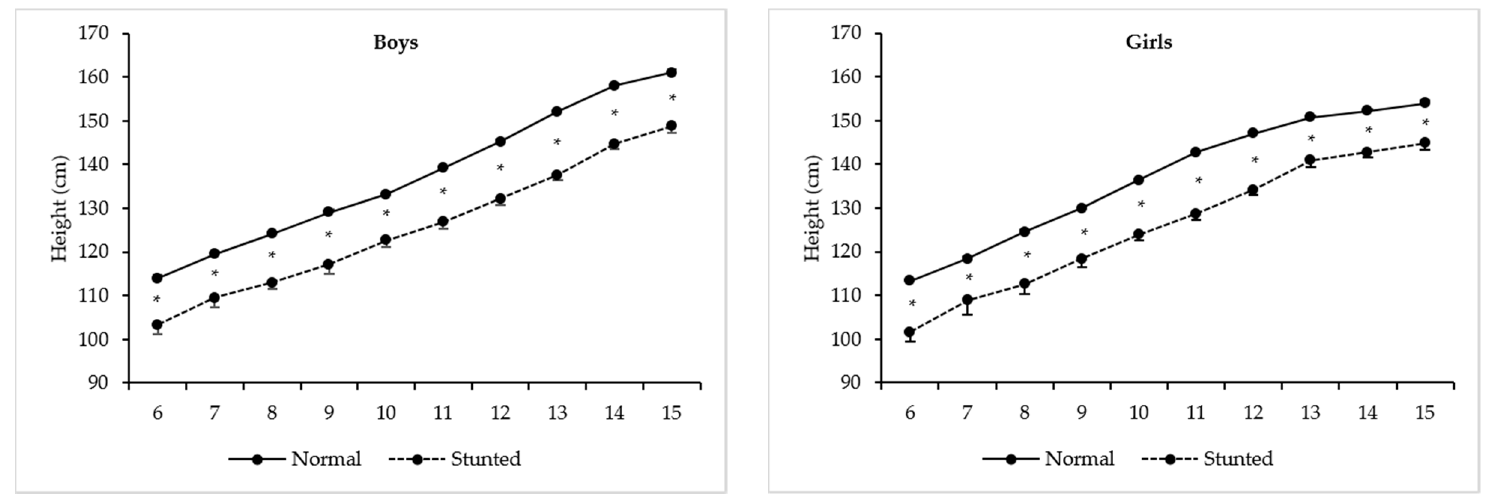
ff erences; 95% Confidence